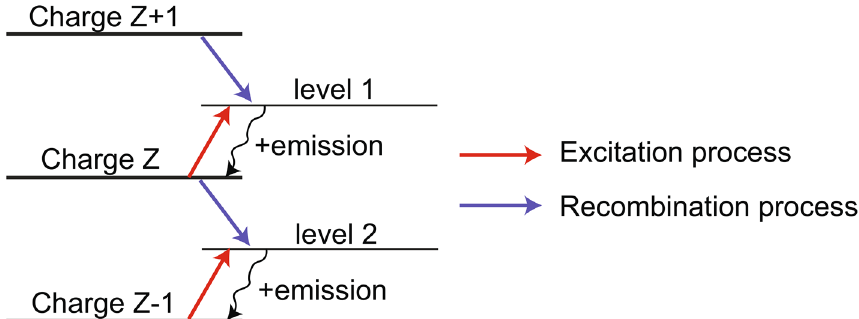
1 , Z , Z 1 , each being − +